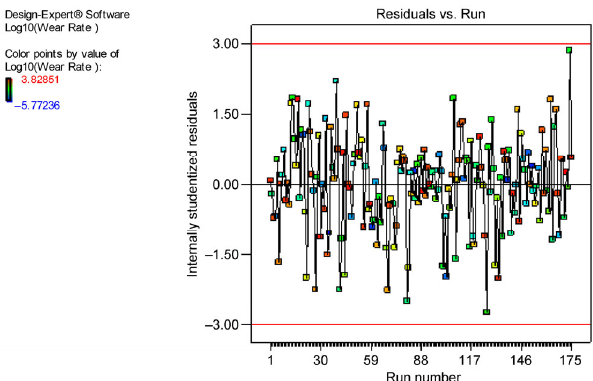
Fig. 5 Distribution of residuals over the experimentation run order for W R